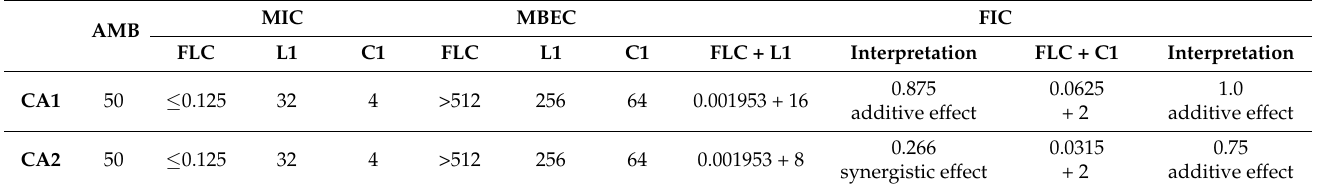
Table 1. Concentration values ( µ g/mL) for both investigated Candida strains (CA1 and CA2) for all tested compounds used in this study: lipopeptides L1 (linear), C1 (cyclic), and fluconazole (FLC), determined in our previous study [26], and amphotericin B (AMB). MIC—minimal inhibitory